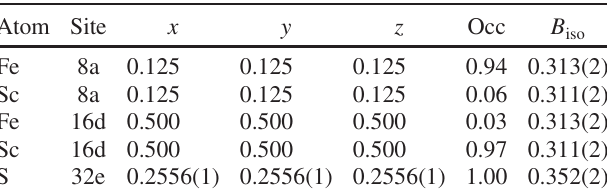
TABLE IV. Atomic parameters obtained from Reitveld refine- ments of synchrotron x-ray diffraction data at 100 K for FeSc 2 S 4 samples used in this work. The space group is F lattice parameter is refined to a ¼ 10 . 51115 ð 1 Þ Å. Reitveld refinements result in χ 2 ¼ 2 . 83 and R